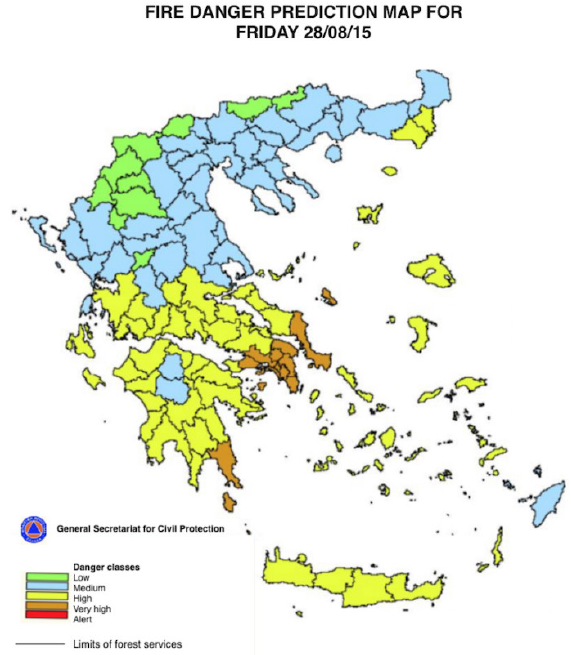
Figure 1. Daily fire prediction map at national scale for the day 28 August 2015. A class for fire danger prediction is assigned for each province of the country.